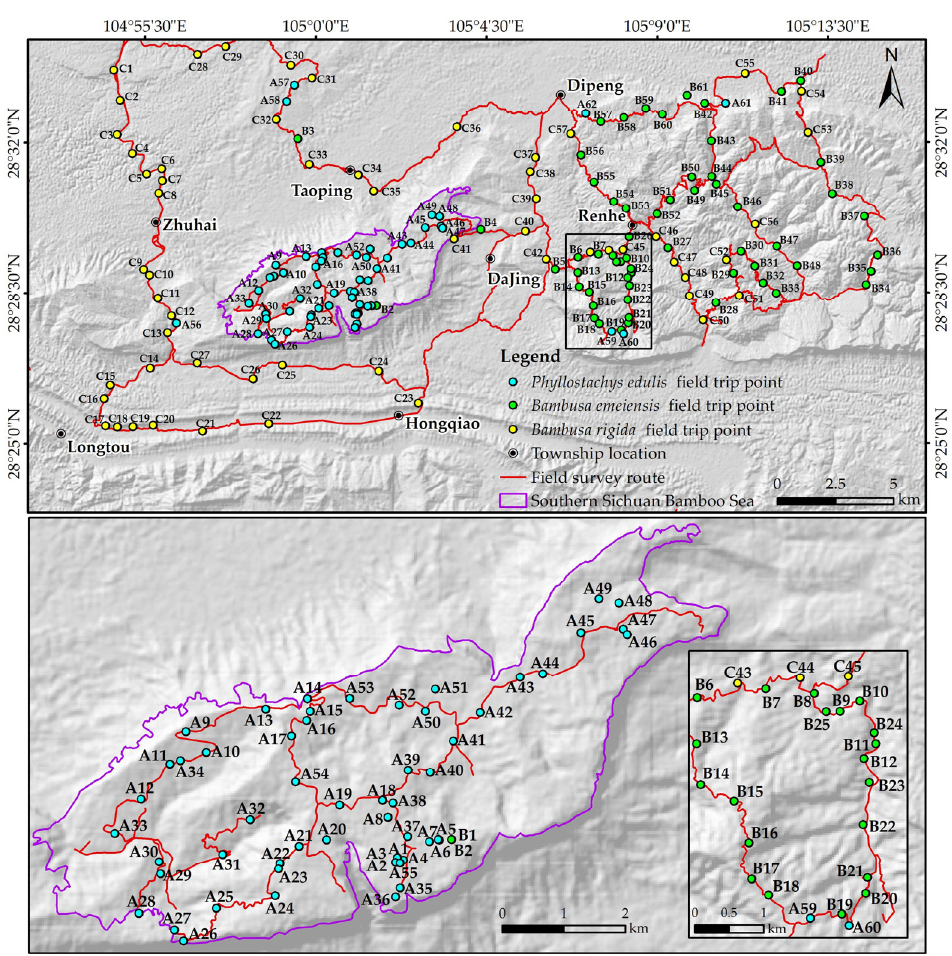
Figure 2. Map of field survey points and zoom-in maps.